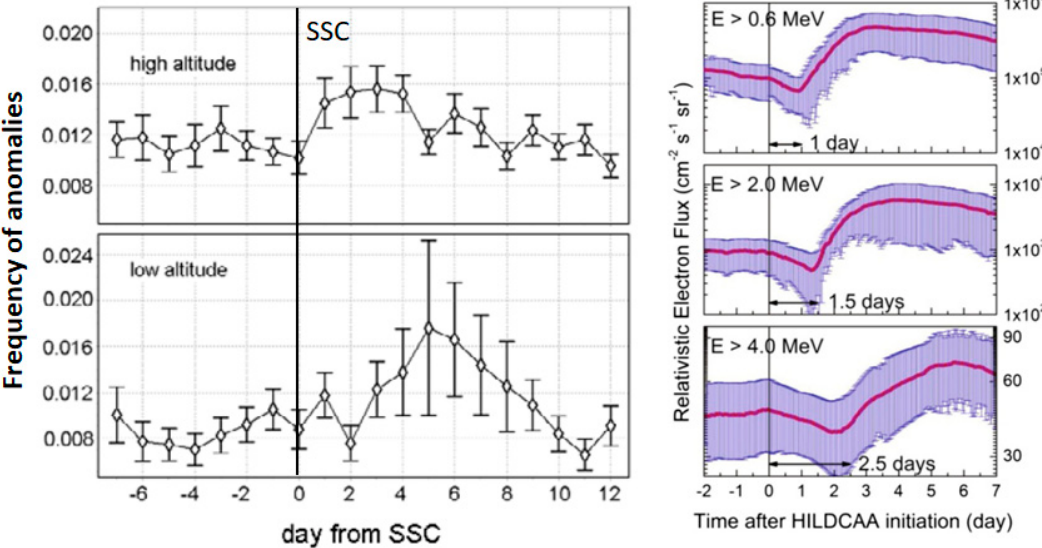
Figure 18. ( left ) The frequency of spacecraft anomalies as a function of time elapsed since the storm sudden commencement (SSC) (from [161]). ( right ) The progressive increase in relativistic electron flux at various energies following a geomagnetic storm due to a high-intensity, long-duration continuous auroral electrojet activities (HILDCAA) event (from [165]). The initial dip in the electron flux is due to the compression of the magnetosphere by the HSS. Table 3. Particles in various energy ranges, their sources, and their